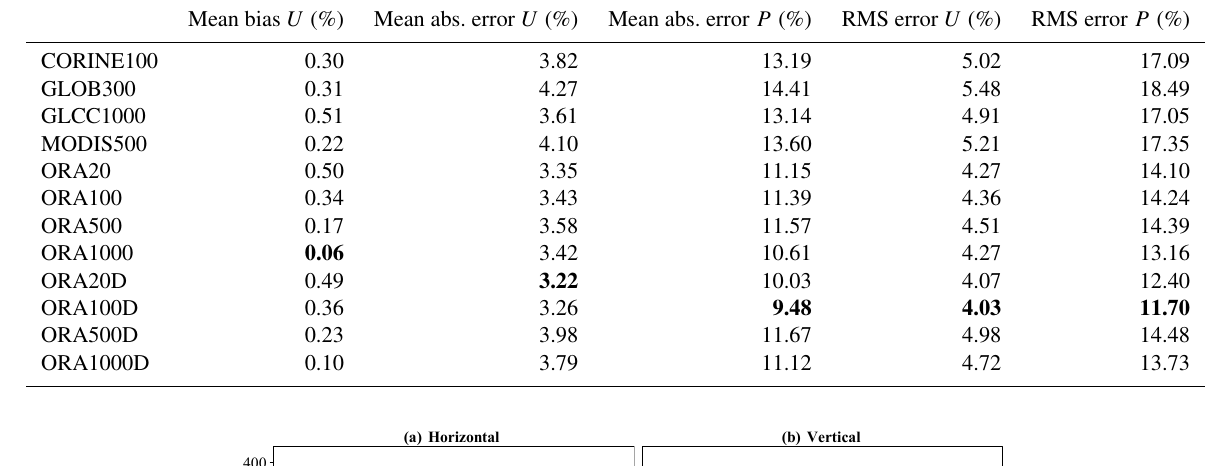
q (cid:0) 100( y (cid:1) 2 . The lowest value of an error i − x i ) /x i